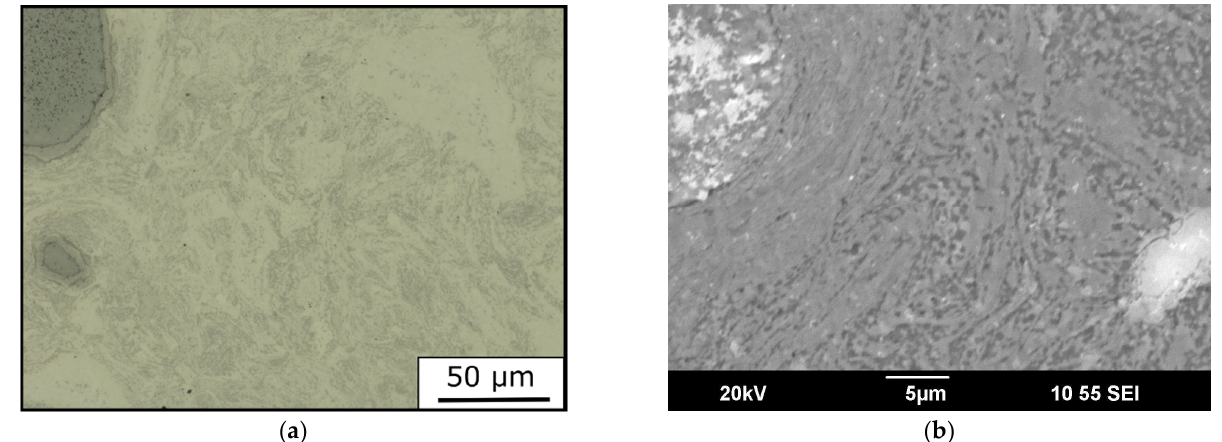
Figure 9. Micrographs of the MPEA_HIP sample: ( a ) light optical image, and ( b ) secondary electron image.